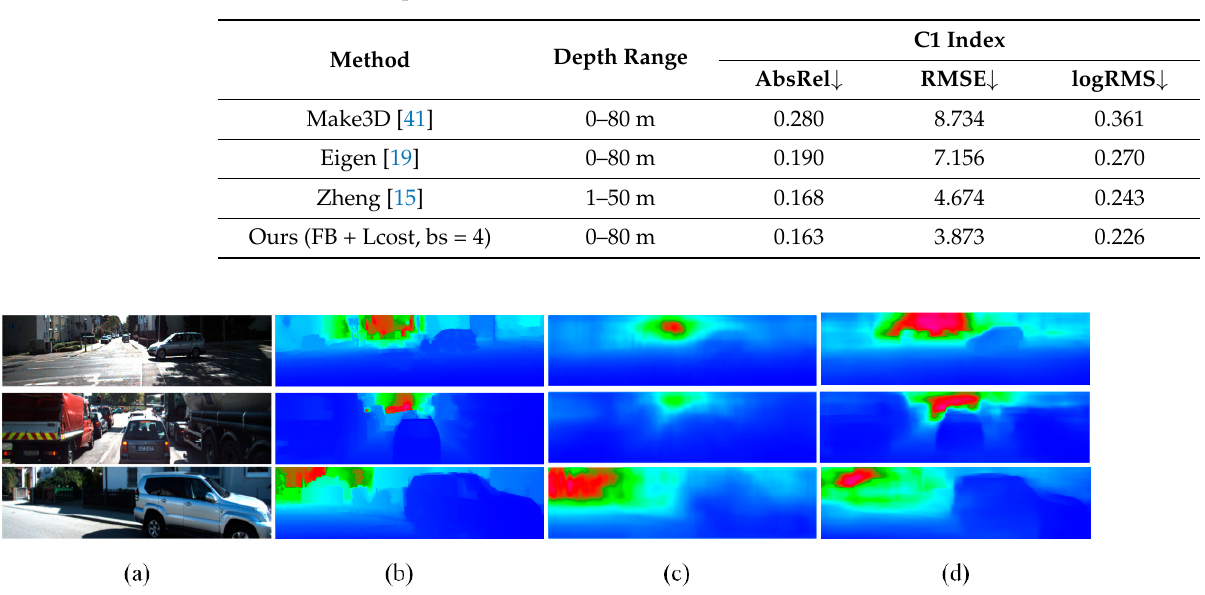
Figure 8. Comparison of monocular depth estimation results of KITTI dataset. ( a ) RGB images; ( b ) ground truth; ( c ) Eigen’s method; ( d ) proposed method.